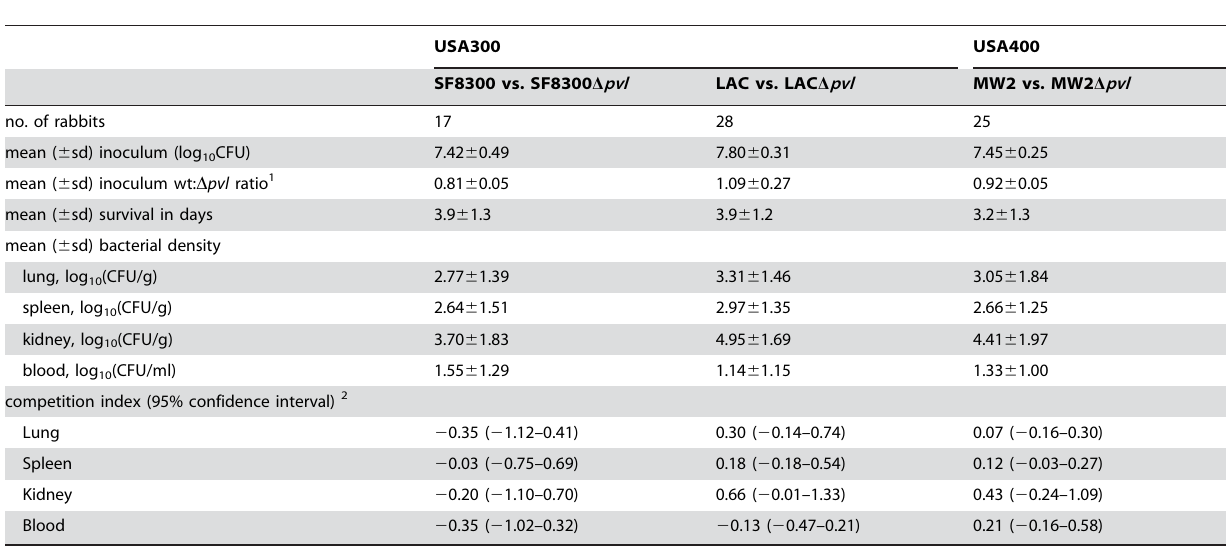
1 Competition assays were used to compare three wild type- D pvl mutant pairs: LAC-LAC D pvl (n=28), SF8300-SF8300 D pvl (n=17), and MW2-MW2 D pvl (n=25), where n is the total number of animals used in each experiment. A 1:1 mixture containing approximately 3 6 10 7 CFUs of wild type parent and 3 6 10 7 CFUs of isogenic D pvl mutant were used to co-infect New Zealand white rabbits via the marginal ear vein. Mean bacterial densities comprising of both wild type and D pvl mutant from vital organs and blood are shown. The competition index (CI), which is the logarithm (log 10 ) of the output ratios of parent and isogenic mutant after correction for variations in input ratios, are shown. A positive CI value indicates enhanced tissue infectivity of the parent, whereas a negative CI value indicates enhanced tissue infectivity of the mutant; a CI=0 is the no-effect value. 2 The null hypothesis (CI=0) that there was no difference in bacterial densities between parent and isogenic D pvl mutant in rabbit vital organs was tested using a paired Student’s t test. All two-tailed P values were not statistically significant ( P . 0.05).